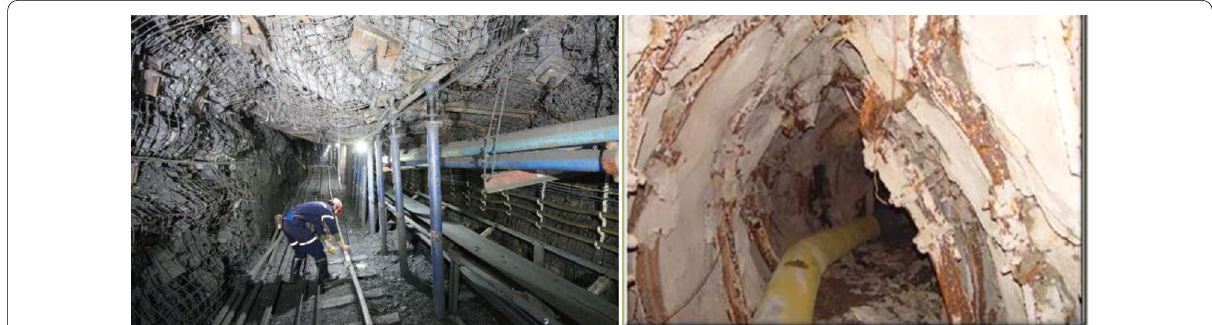
Fig. 1 Rupture‑bulking and large deformation of deep surrounding